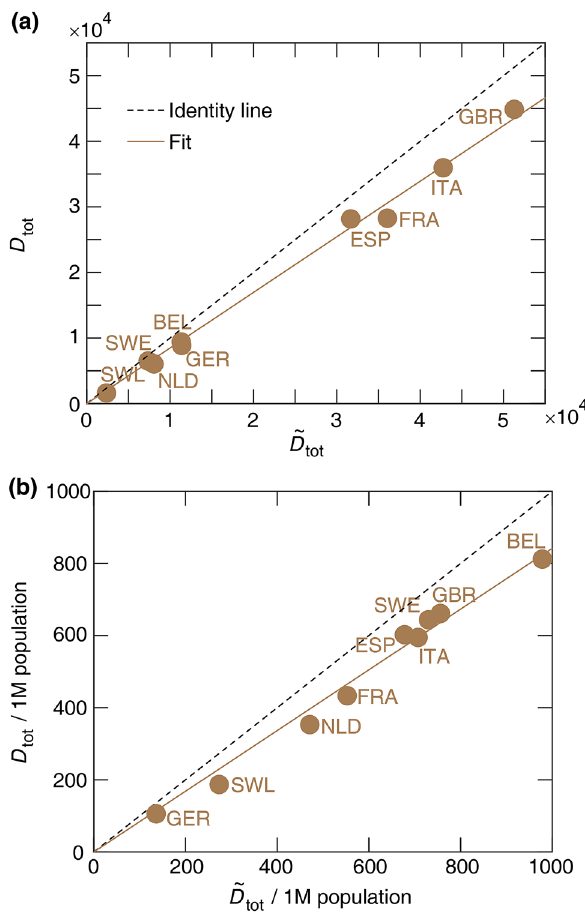
Figure 2. Analytical estimate of the total number of COVID-19 deaths ˜ D tot versus D tot , the actual total death toll ( a ). ( b ) The same data are presented as per million (1M) population. The dashed and solid lines represent the identity and a linear regression, respectively. The slope of the linear regression is 0.85 ± 0.01 ( a ) and 0.84 ± 0.02 ( b ). Pearson coefficients of determination are ( a ) r 2 = 0.99 ( p < 0.001 ) and ( b ) r 2 = 0.98 ( p < 0.001 ) . Statistical data analysis was performed using MATLAB (version 2017b, The MathWorks,